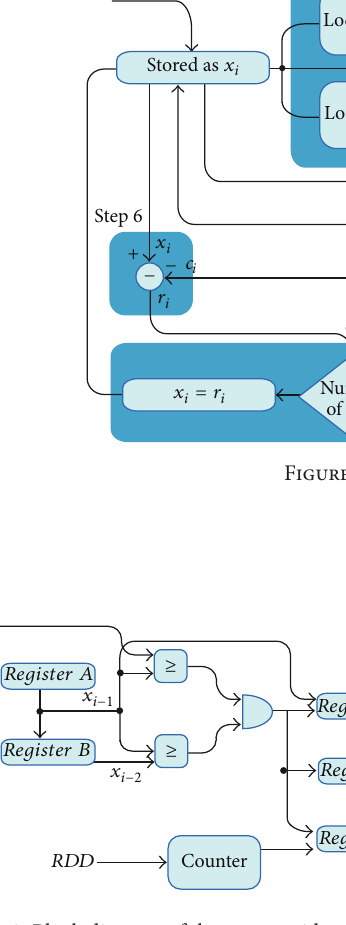
Figure 9: Block diagram of the extrema identification module.